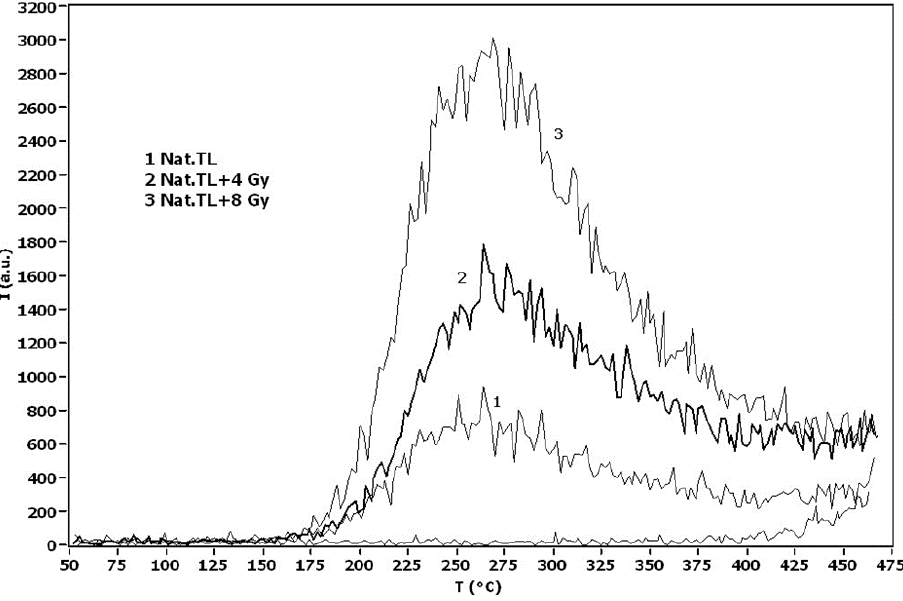
Figure 1. TL glow-curves, example of a clay core extracted from the Lupa Capitolina